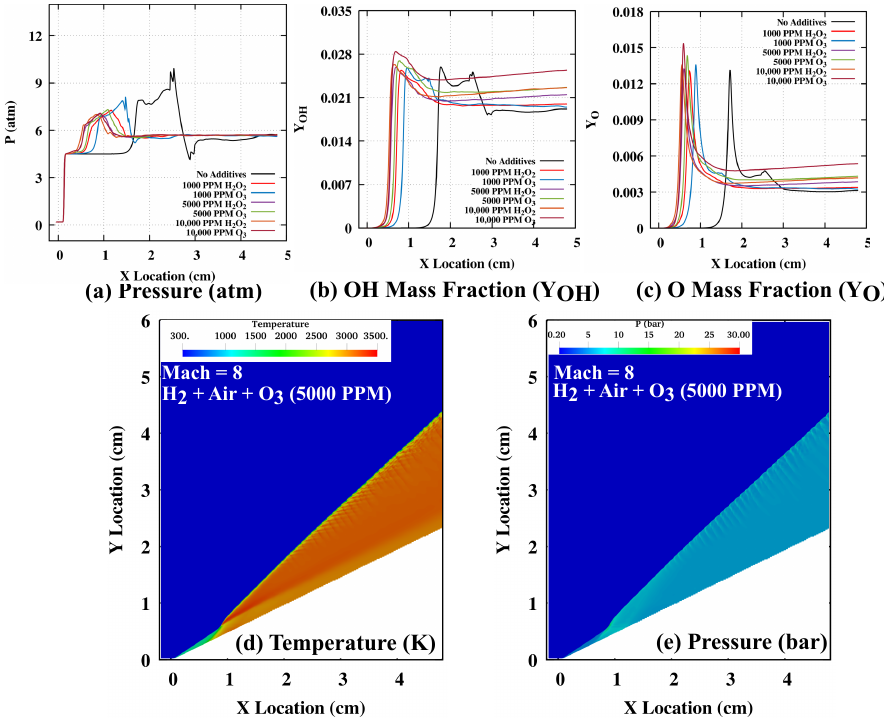
Figure 7. ( a ) Pressure, ( b ) OH Radical Mass fraction, ( c ) O variation along the wedge surface, ( d ) temperature and ( e ) pressure contour for 5000 PPM O 3 addition at Mach